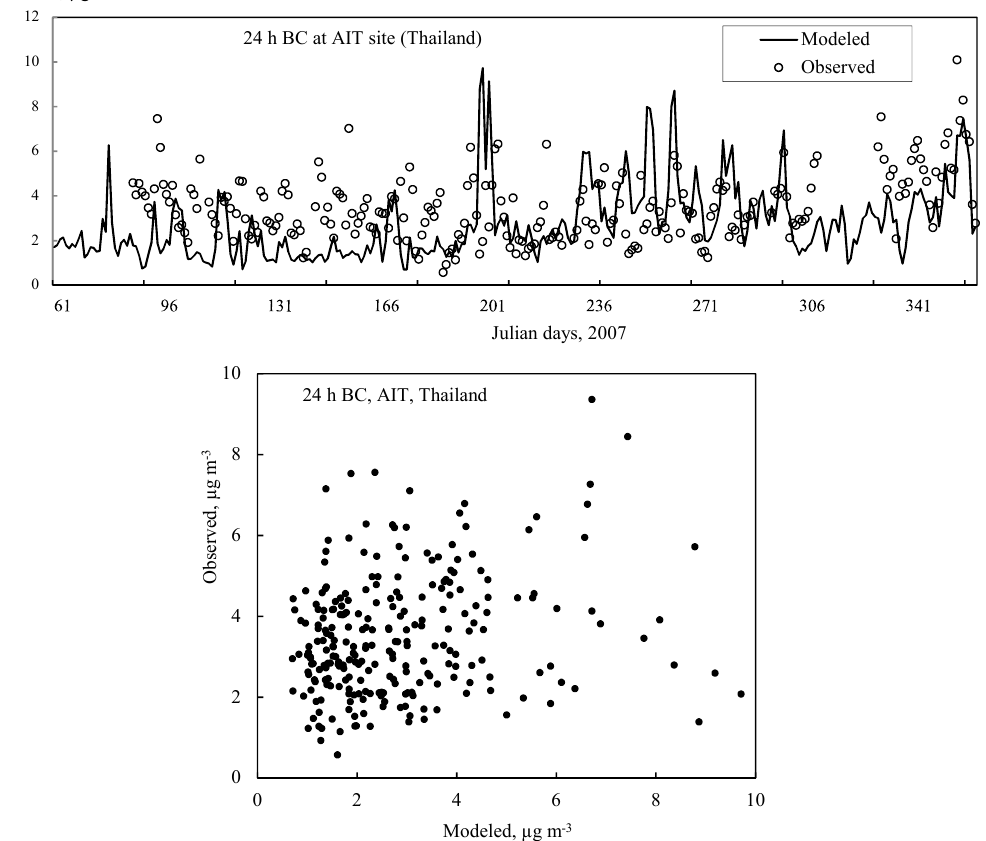
Figure 5. Time series comparison and scatter plot of modeled vs. observed 24h elemental carbon in AIT site, 2007.